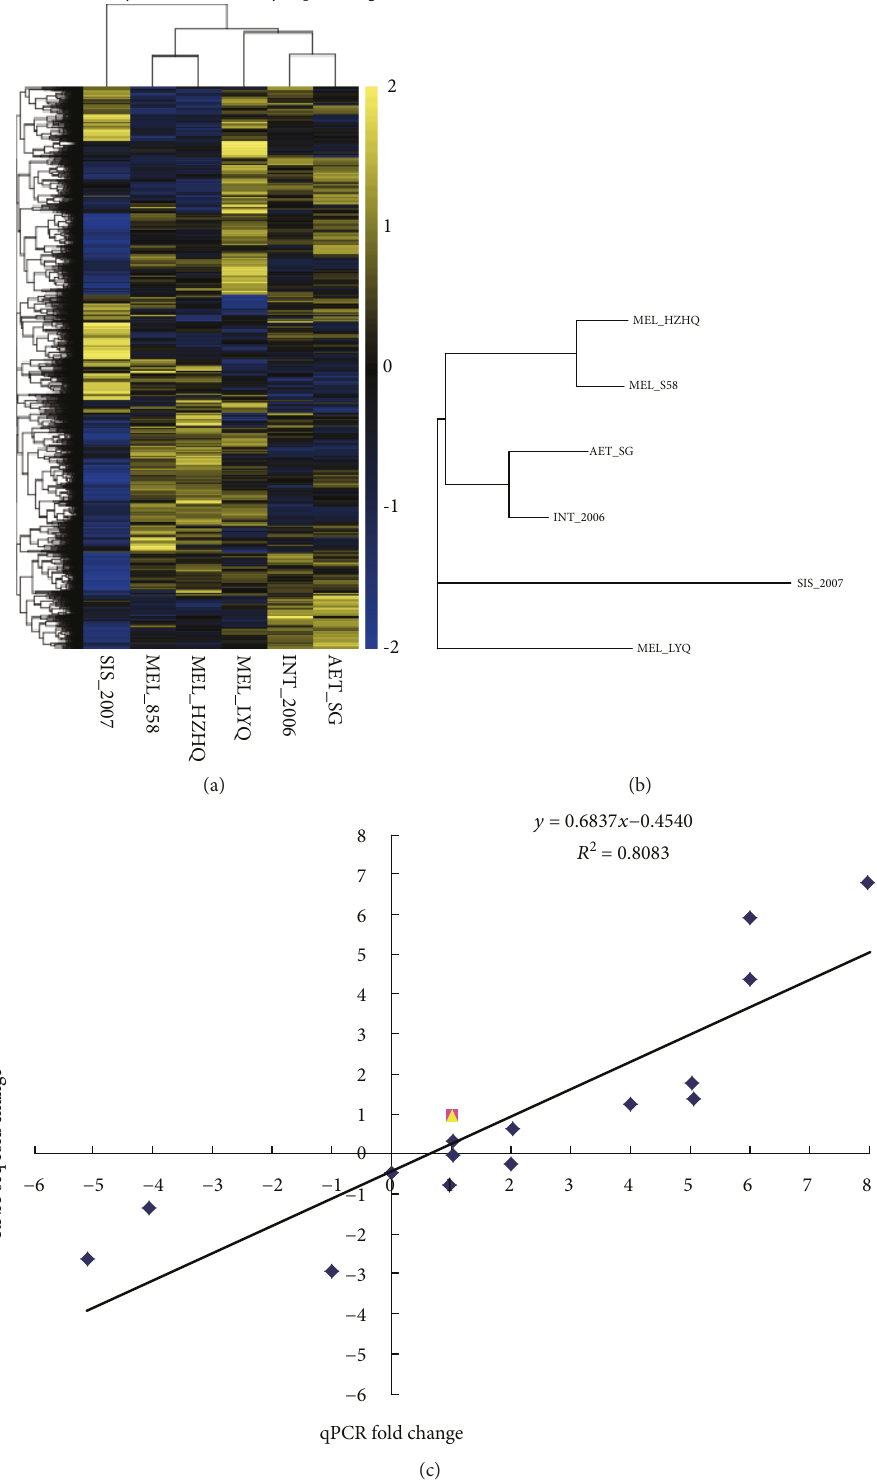
Figure 4: (a) The heatmap depicting expression pro fi les of orthologous genes in the six eggplant species S. sisymbriifolium (SIS_2007), S. aethiopicum (AET_SG), S. integrifolium (INT_2006), and S. melongena cultivars HZHQ (MEL_HZHQ), LYQ (MEL_LYQ), and S58 (MEL_S58). Scaled log2 expression values are shown with yellow and blue indicating high and low expressions, respectively. (b) Hierarchical clustering of the di ff erentially expressed genes using the RNA-seq data derived from six samples based on RPKM values. (c) Correlation of fold change values from RNA-seq and qPCR based on the SmActin expression. The R 2 value is